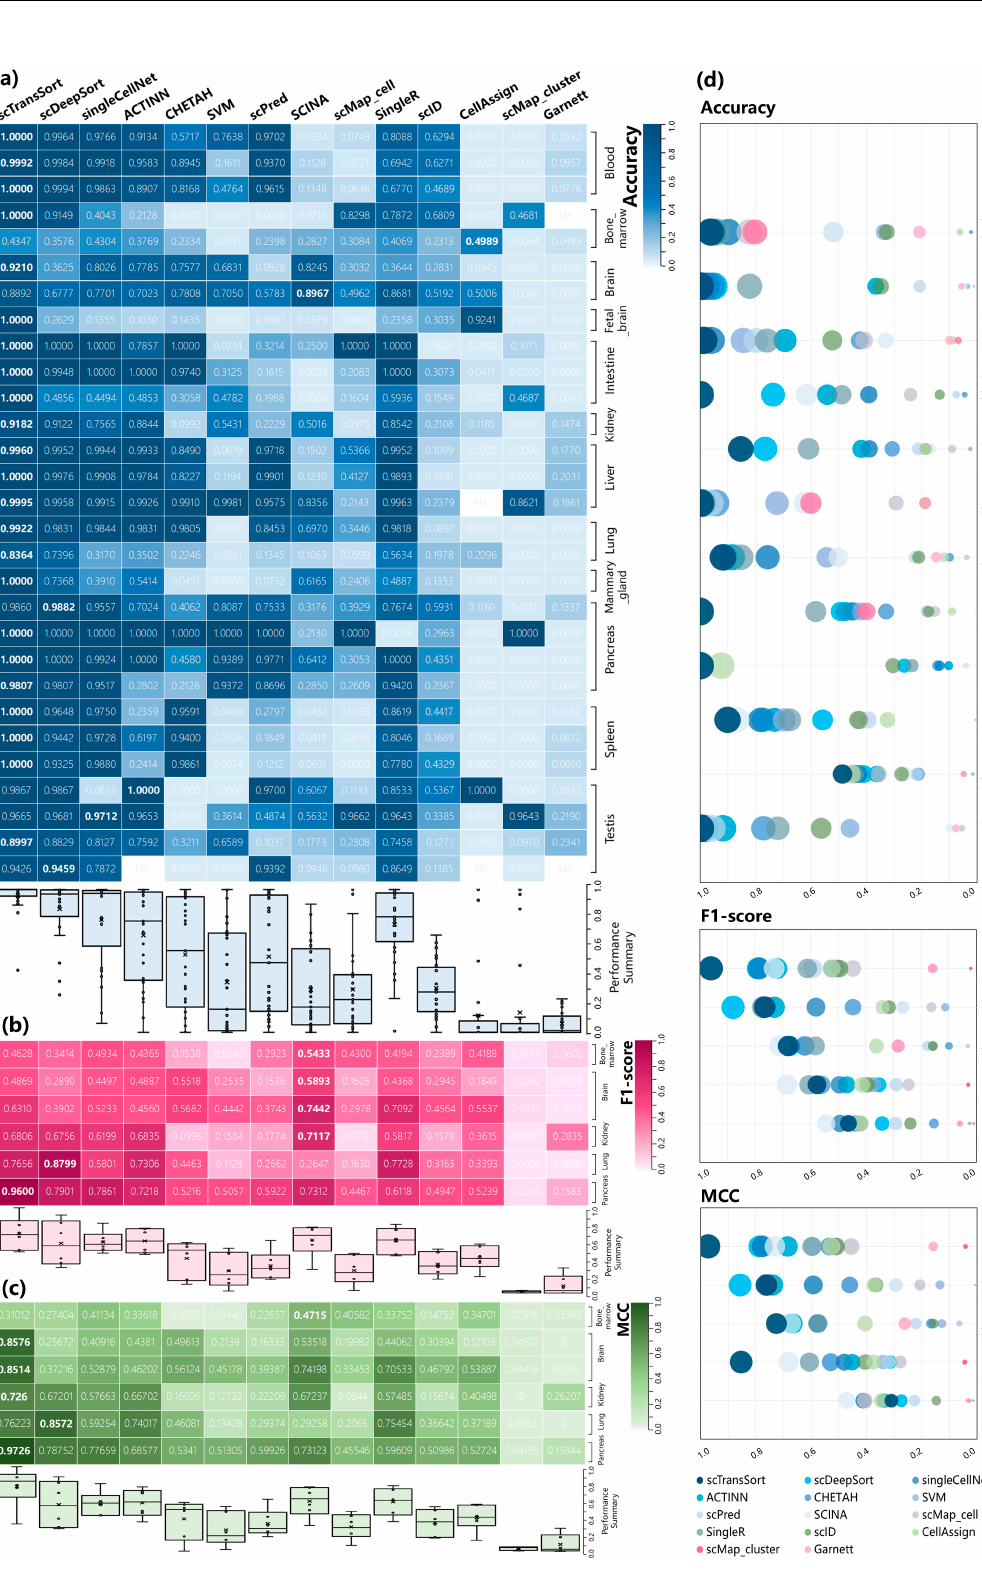
Figure 5. Performance comparison of scTransSort on mouse external test datasets (accessed on 1 June 2022). ( a ) Heat maps and boxplots of accuracy comparisons for different methods on 29 datasets from 12 tissues; ( b ) Heat maps and boxplots of the mean F1 score comparison; ( c ) Heat maps and boxplots of the mean MCC comparison. The bolded font indicates the top-ranked method for each dataset; ( d ) The bubble charts summarize the accuracy, mean F1 score, and mean MCC of the different methods in each